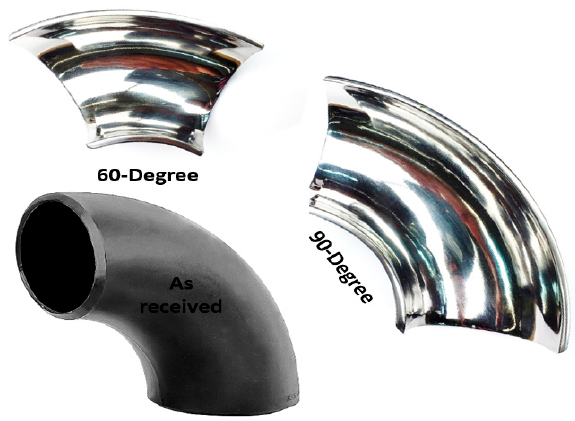
Figure 1. Elbow test specimen.